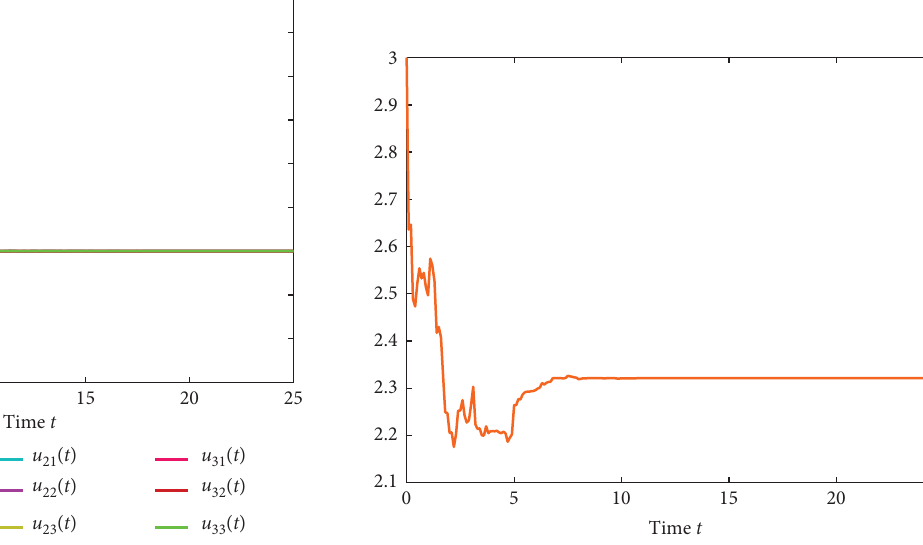
Figure 10: Response of